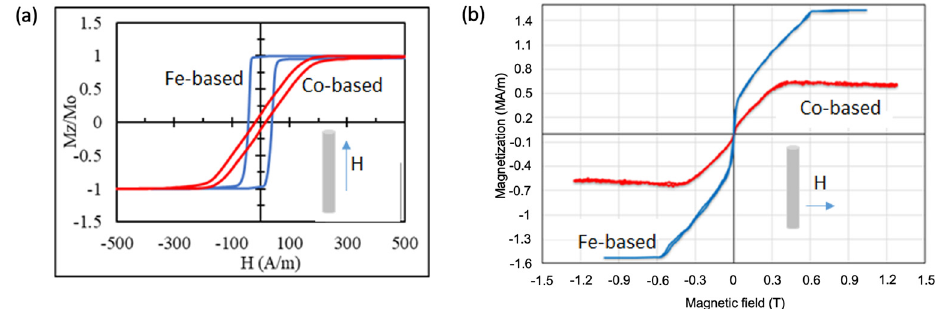
Figure 4. Hysteresis loops of amorphous microwires of Fe-based (Fe 77.5 Si 7.5 B 15 ) and Co-based (Co 67.5 Fe 4.5 B 14 Si 11 Cr 3 ) compositions magnetised by an axial field ( a ) and a perpendicular field ( b ). The axial and perpendicular curves were measured using an inductive method and vibrating sample magnetometry, respectively. Wires with a diameter of 20–25 microns have a glass coating with a thickness of 4–4.5 microns. The saturation magnetisation is 1.5 MA/m and 0.55 MA/m for Fe-based and Co-based wires, respectively. The wires have different anisotropies: axial for Fe-based and circumferential for Co-based, but both are magnetised along the axis by a small field below 150 A/m. A relatively small field of ~100 mT is required to induce a large perpendicular magnetisation of 0.5 MA/m in Fe-based wire.